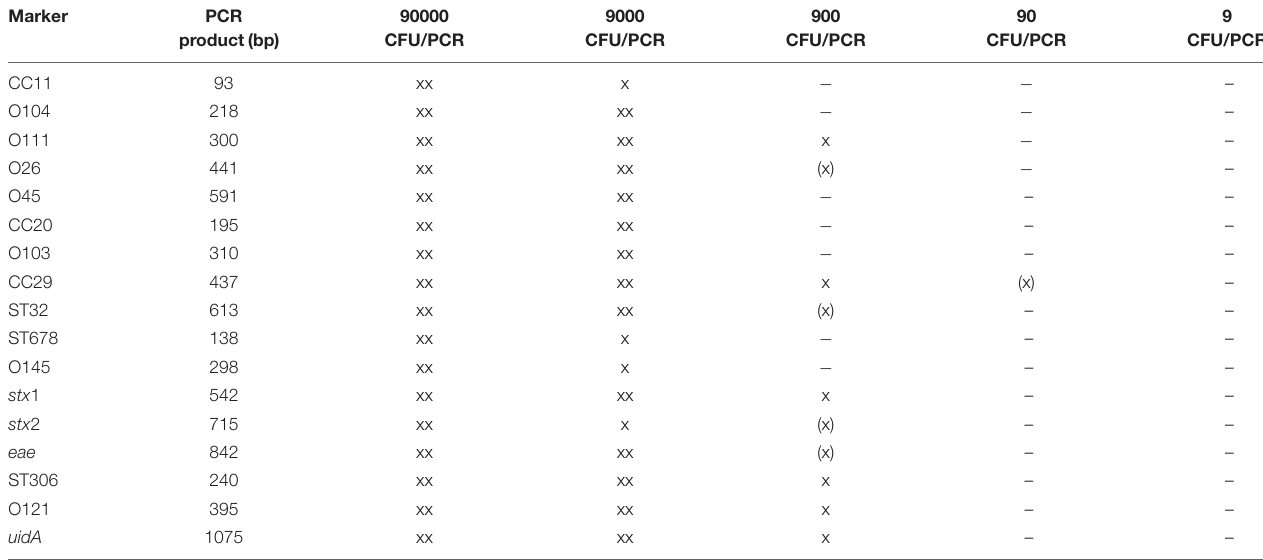
TABLE 6 | Results of milk dilution series with 28 PCR